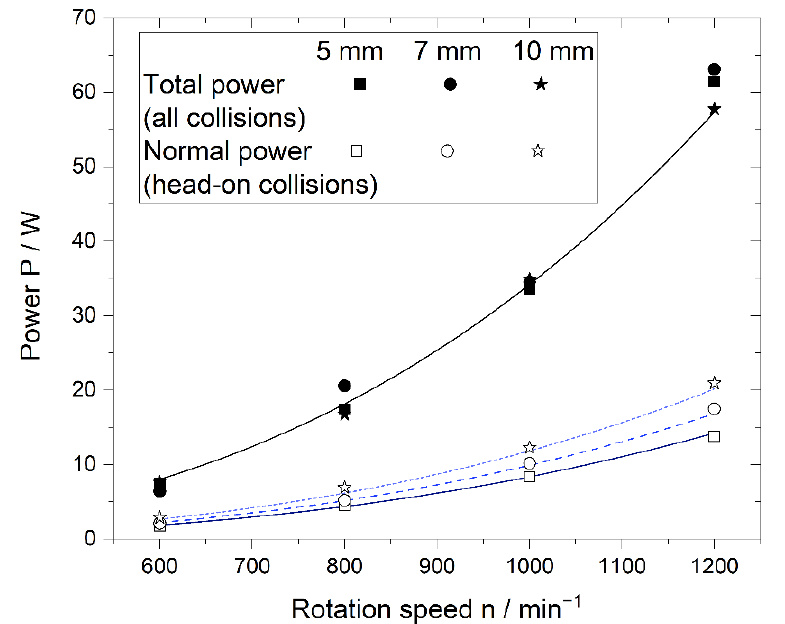
Figure 4. Total and normal power input in dependence on rotation speed for varied media sizes, φ (cid:2923)(cid:2915)(cid:2914)(cid:2919)(cid:2911) = 0.3 (fit functions are based on Equations (12) and (13)).